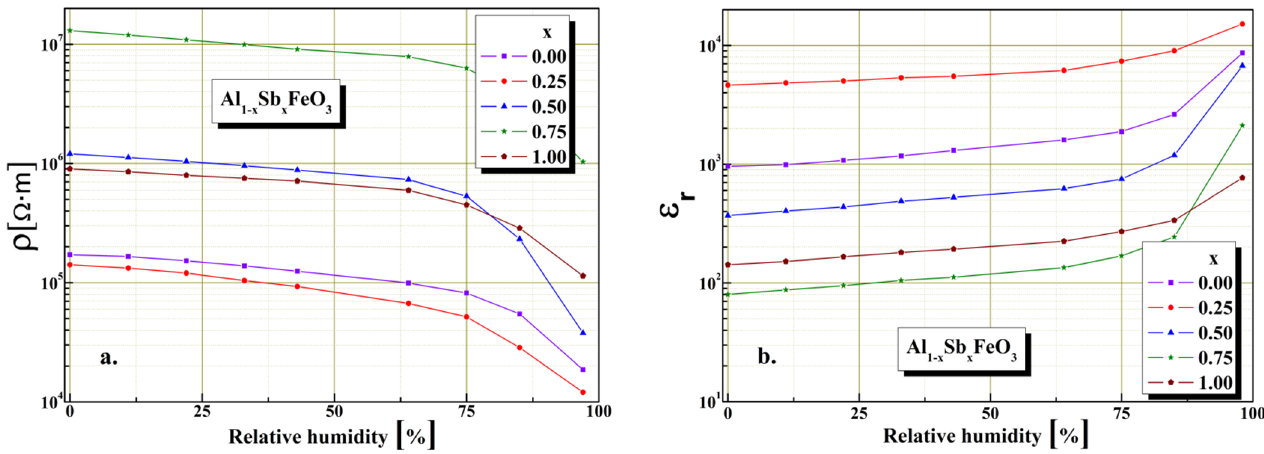
Figure 8. Humidity characterization: ( a ) resistive sensor and ( b ) capacitive sensor for Al 1 − x Sb x FeO 3 perovskites.